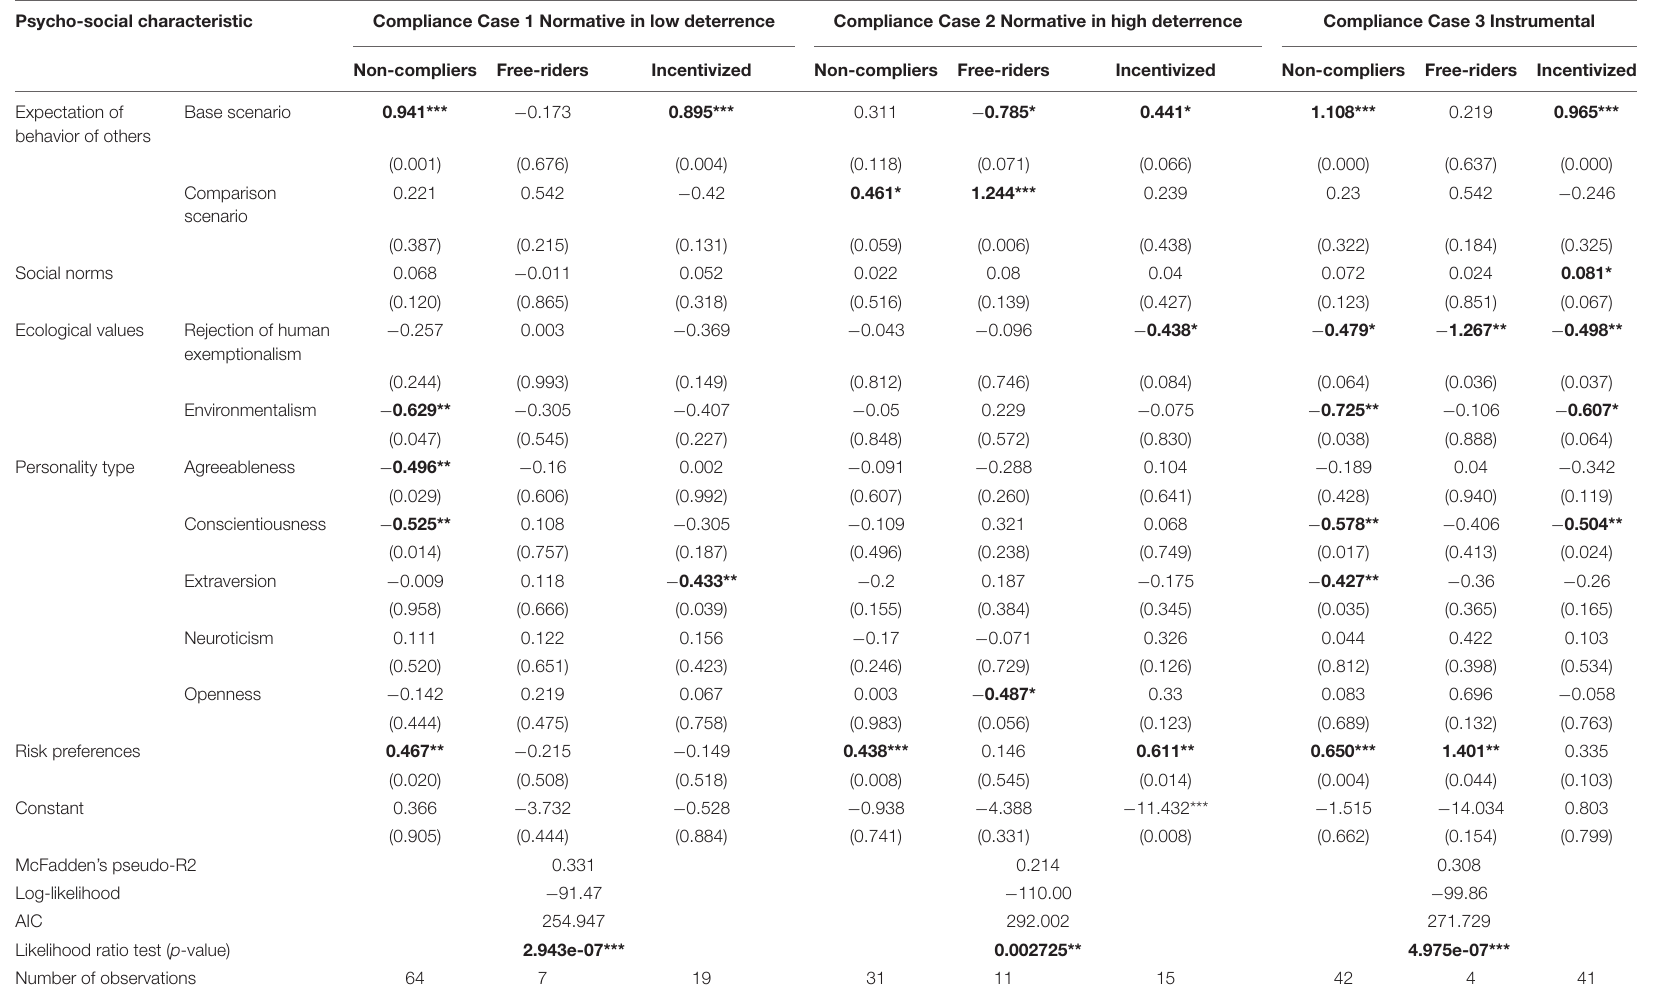
TABLE 4 | Multinomial model results on responses to normative and instrumental incentives.